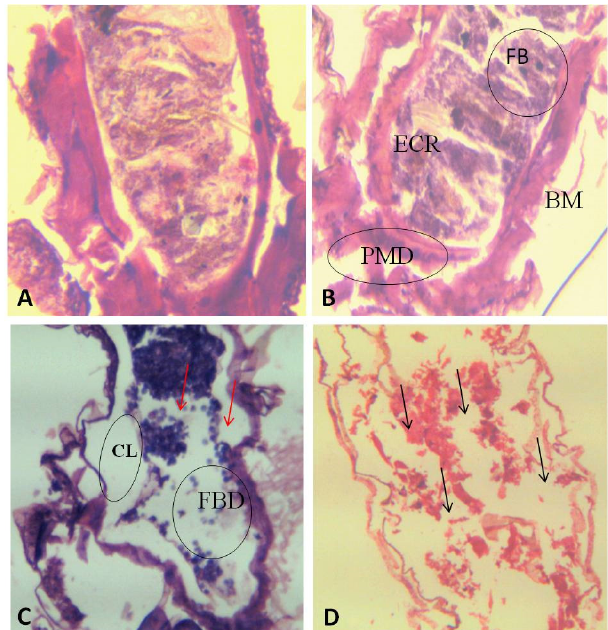
Figure 6. Longitudinal sections in the posterior region of the midgut of an A. aegypti 4th instar larvae, magnification: 10×. ( A ) control; ( B ) a larva under treatment with 10 ppm selenium nanoparticles; ( C ) a larva under treatment with 50 ppm selenium nanoparticles; ( D ) a larva under treatment with 100 ppm selenium nanoparticles. The arrow indicates the disordered and broken epithelial cell layer, complete breakup of mid-gut and caeca and collapsed larval structure, respectively. Mu: muscles; FB: food bolus; CL: cell lysis; PMD: peritrophic membrane damage; FBD: food bolus damage; ECD: epithelial cells damage; CS: separated cells.